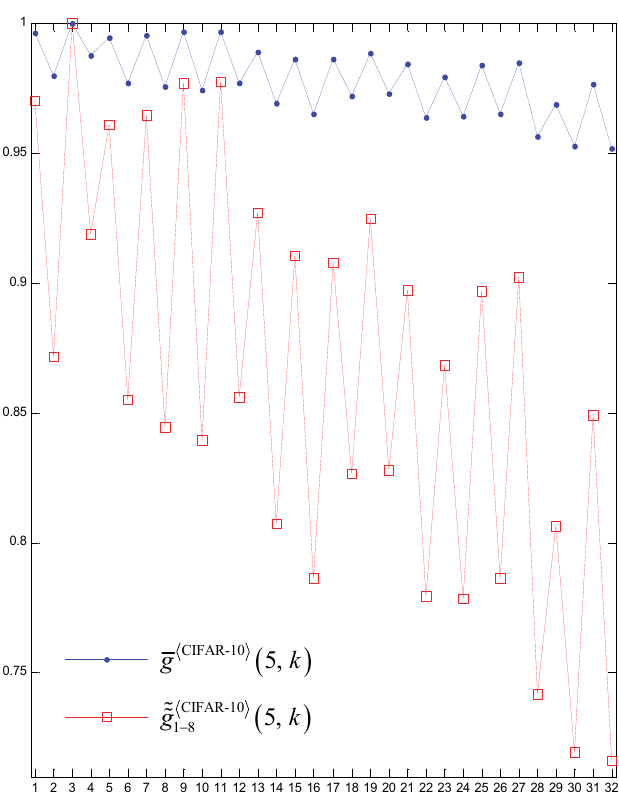
Fig. 12. The normalized averaged RERD (16) and the normalized averaged 4 N  on CIFAR-10. Maxima coincide at 4 k  . final-epoch RERD (17) by ConvL